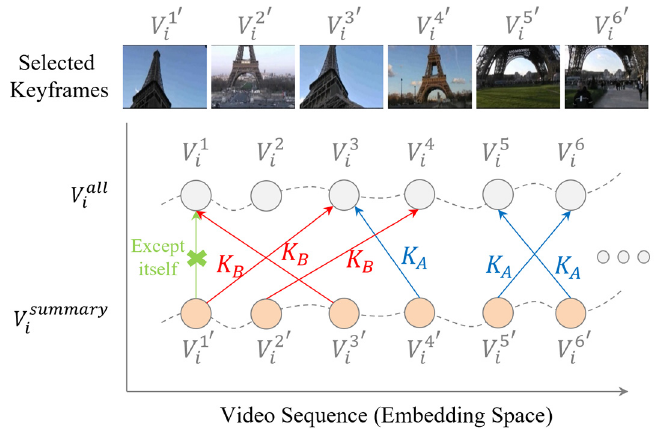
Figure 5. Example of the temporal consistency reward function.